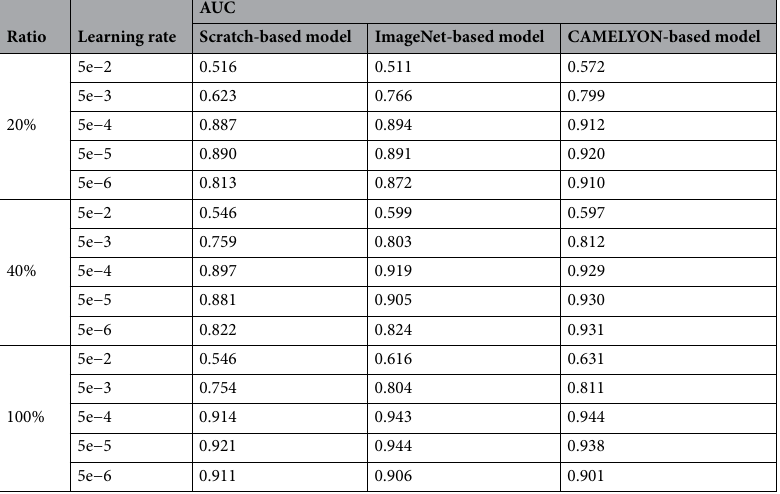
Table 3. Performance comparison of models based on different initial weights and learning rates for different ratios of the training dataset. AUC was measured for patch-level evaluation in AMC dataset.